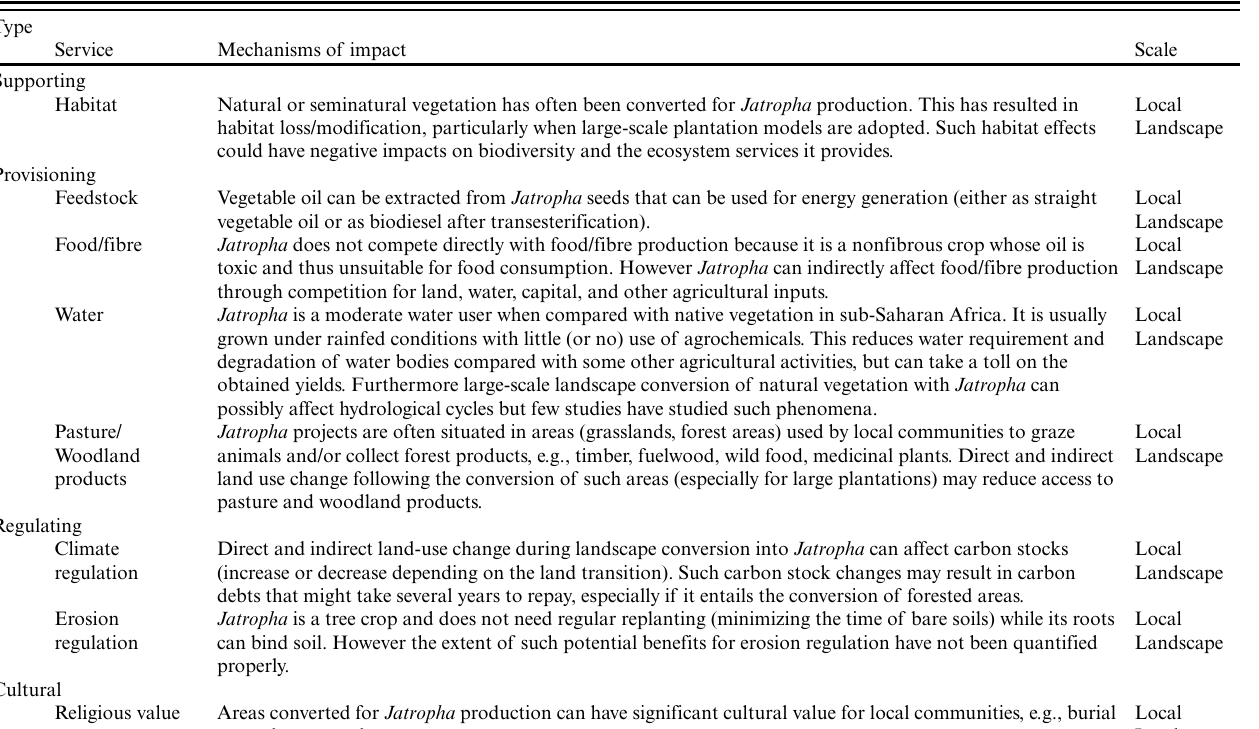
Table 1 . Ecosystem services impact mechanisms of Jatropha cultivation in sub-Saharan Africa. Adapted from Gasparatos et al. 2012,